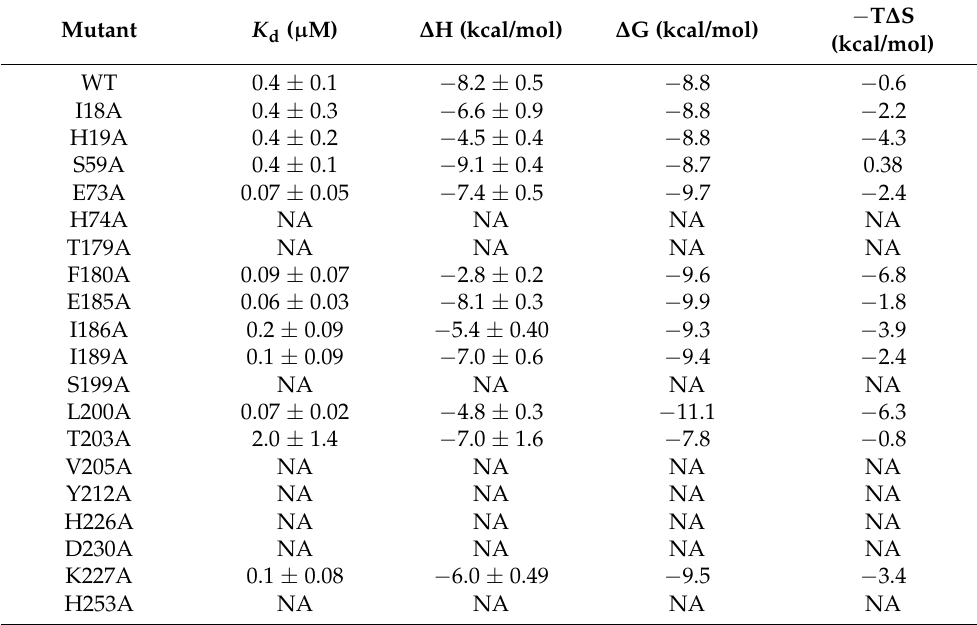
Table 2. Determination of affinity between AalpxC and mutants with